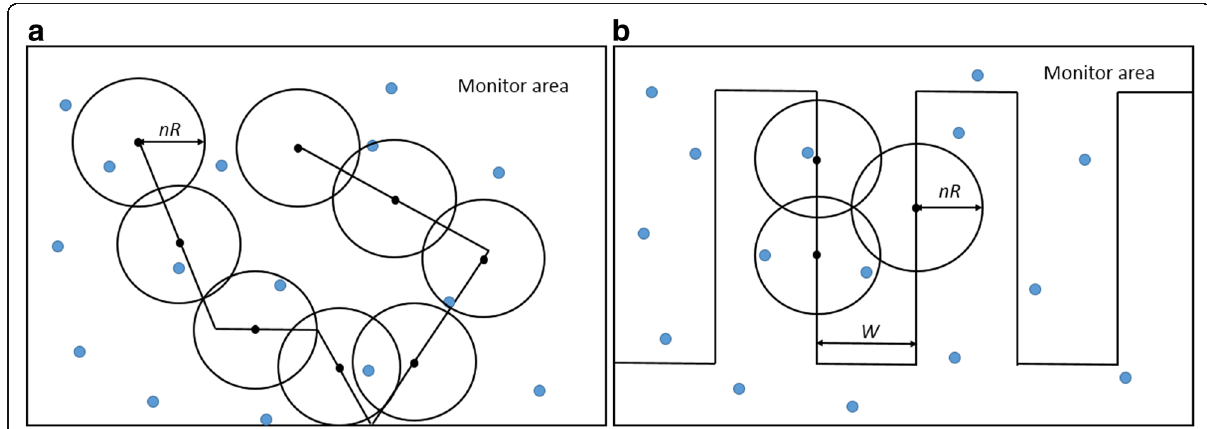
Fig. 3 Path selection for the mobile beacon in MBATS. a The random path. b The designed